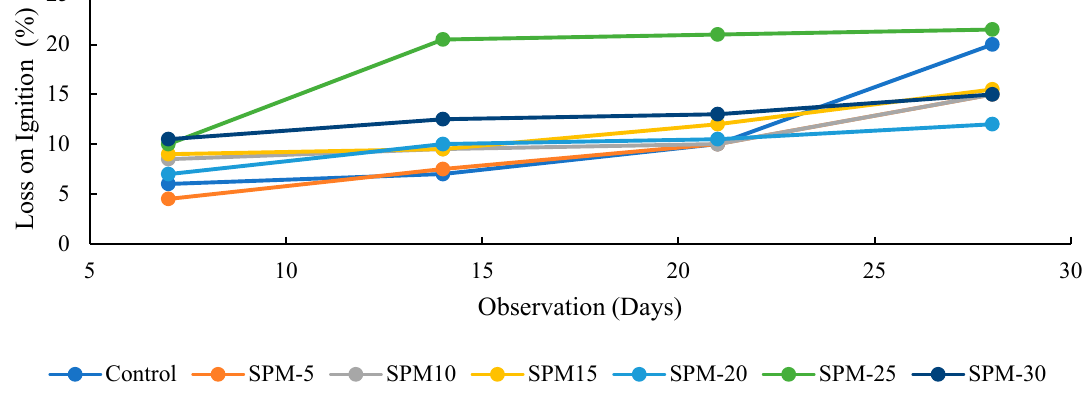
Figure 7. Loss on ignition (LOI) of SP-based mortars.